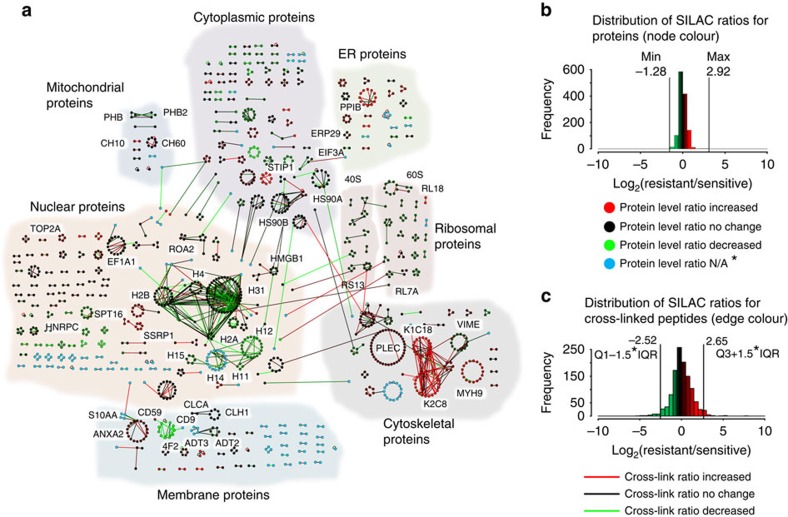
Quantitative interaction network.(a) Quantitative crosslinked peptide interaction network consisting of 1,308 nodes representing unique crosslinked peptides connected by 1,166 edges representing crosslinks between two peptides. Loop edges connecting the same node to itself represent unambiguous homodimer crosslinked peptide pairs. Nodes are grouped in circular clusters according to their protein assignment. A force-directed layout reveals clusters of linked proteins corresponding to general functional class or subcellular localization, which are indicated by coloured shapes encompassing clusters of linked proteins. (b) Distribution of log2(Resistant/Sensitive; R/S) ratios (average values obtained from analysis of six biological replicates) obtained by traditional SILAC analysis representing relative global protein level changes between the HeLa and HeLa/SN100 cell lines. The histogram is colour coded to match the node colour in the network. Red coloured nodes represent proteins with increased relative expression levels in the chemoresistant cell line versus the sensitive cell line, while green coloured nodes represent proteins with decreased relative expression levels in the chemoresistant cell line versus the sensitive cell line. Black coloured nodes represent proteins that did not have a measureable change between the two cell lines. *Blue nodes represent proteins for which no R/S ratio was obtained. (c) Distribution of log2(R/S) ratios (average values obtained from analysis of five biological replicates) for the crosslinked peptide pairs quantified between the HeLa and HeLa/SN100 cell lines, colour coded according to match the edge colour in the network. Red, green and black coloured edges correspond to relative changes in crosslinked peptide levels between the resistant and sensitive cell lines with the same colour coding scheme as for the nodes.